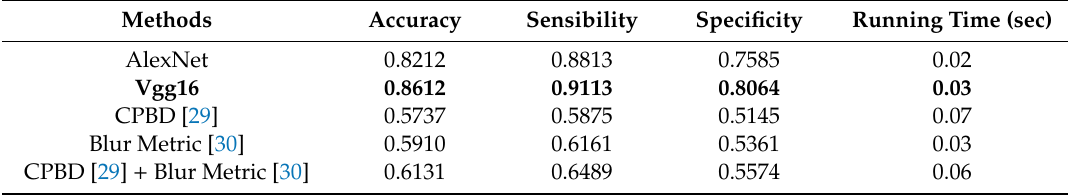
Table 5. Performance comparison for the quality analysis of the OD